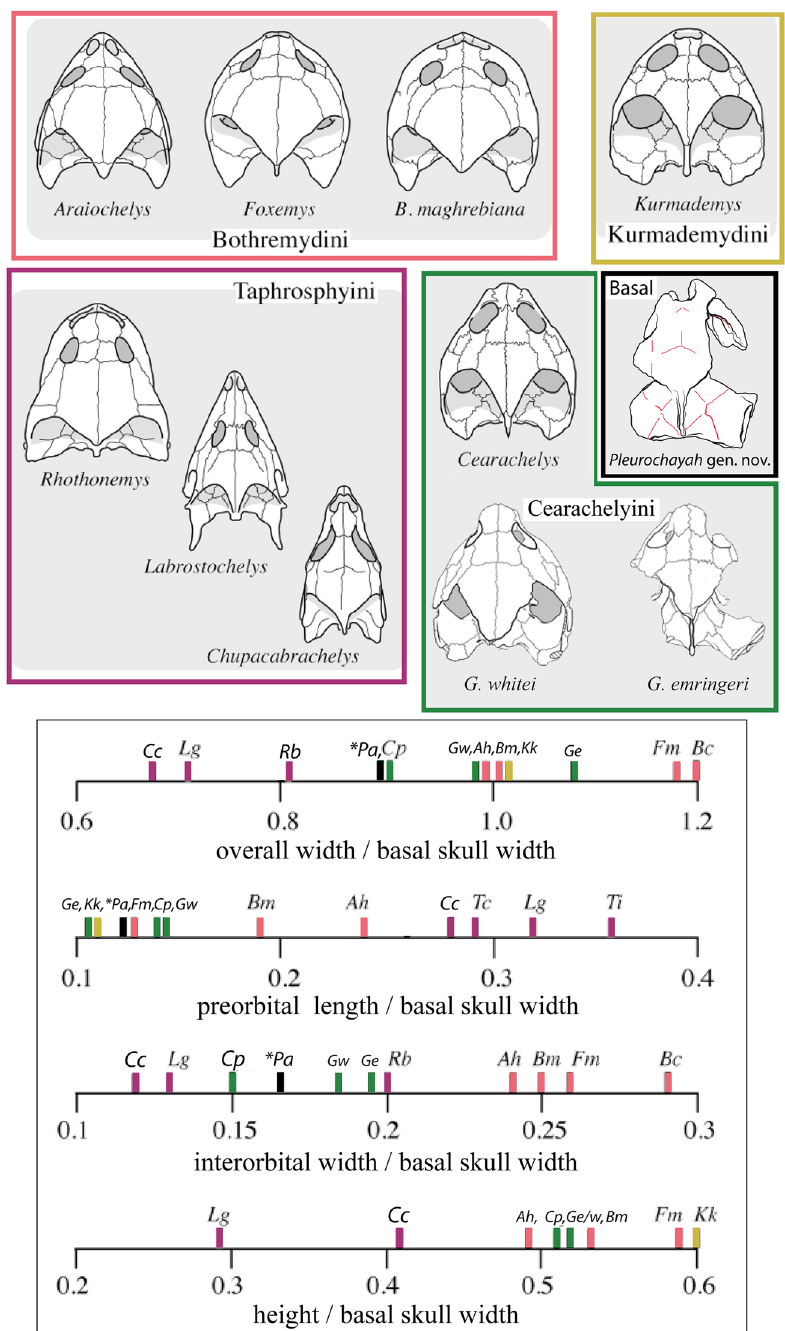
Figure 7. Cranial comparison of selected Bothremydidae skulls in dorsal view, standardized to comparable length. Scales show three ratios of standard skull measurements for bothremydids: ( Ah ) Araiochelys hirayamai , ( Bc ) Bothremys cooki , ( Bm ) Bothremys maghrebiana , ( Cc ) Chupacabrachelys complexus , ( Cp ) Cearachelys placidoi , ( Fm ) Foxemys mechinorum , ( Ge ) Galianemys emringeri , ( Gw ) Galianemys whitei , ( Kk ) Kurmademys kallamedensis , ( Lg ) Labrostochelys galkini , ( *Pa ) Pleurochayah appalachius , gen. et sp. nov. , ( Rb ) Rhothonemys brinkmani , ( Tc ) Taphrosphys congolensis , ( Ti ) Taphrosphys ippolitoi . Modified from Lehman and Wick 38 , with skull reconstructions of G. whitei and G. emringeri from Gaffney et al. 58 , and remaining skull reconstructions and ratios based on measurements from Gaffney et al. 10 . Parts of figure not to scale. Figure created with Adobe Creative Cloud (Adobe